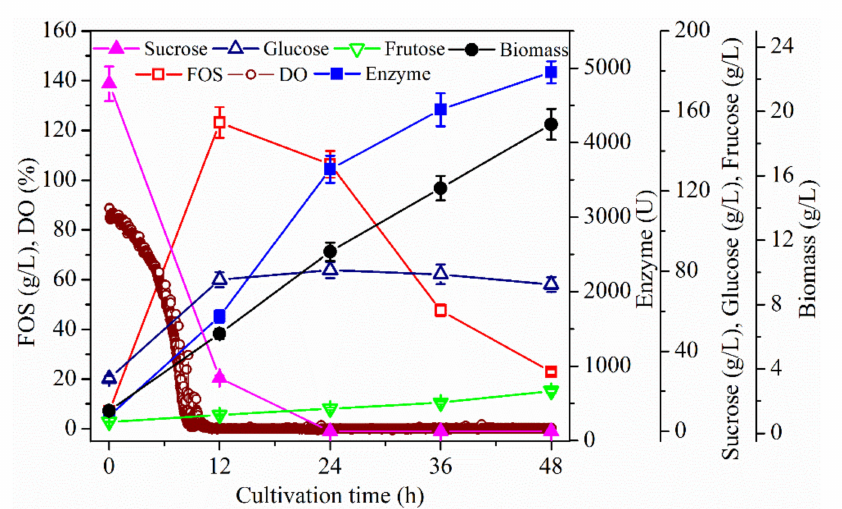
Figure 1. Time profiles of fructo-oligosaccharides (FOS) production in a 2.7 L bioreactor. The A. pullulans ipe-3 strain was cultivated in a 2.7 L bioreactor at pH 5.5, aeration rate 1.8 L/min, 25 ◦ C, and a stirring speed of 600 rpm. The working volume was 1.8 L. Data are given as the mean ± standard deviation (SD), n =